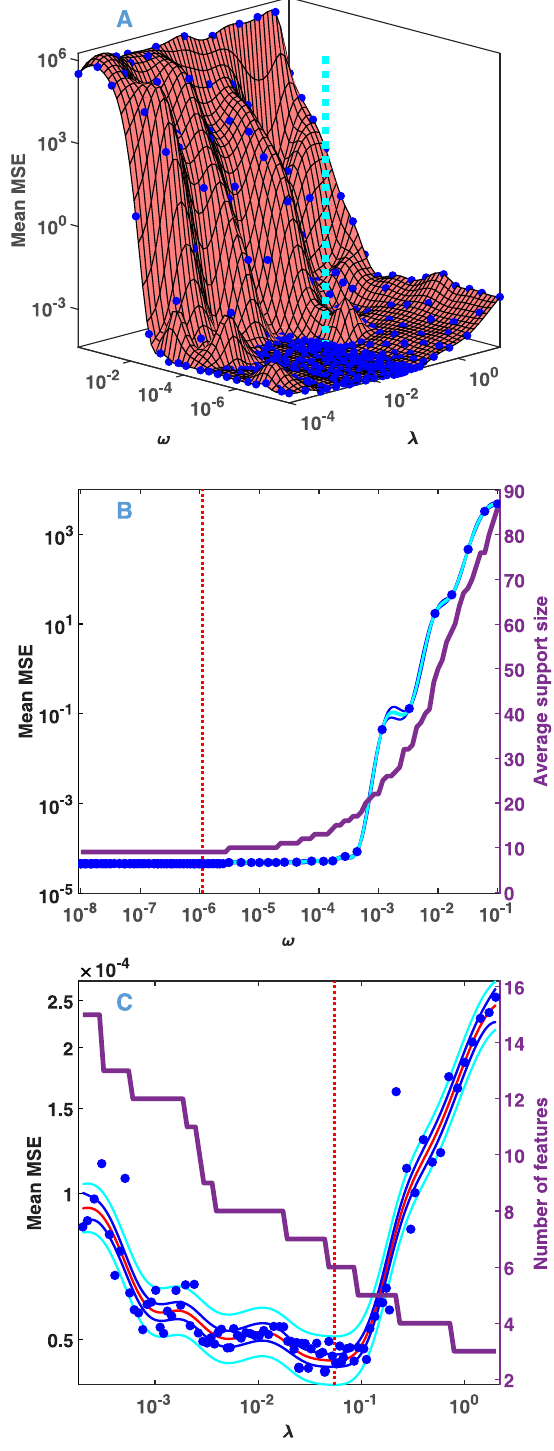
Fig 6. Model selection from the fluorescence kinetic data presented in Fig 5. For details see the legends and caption of Fig 3.